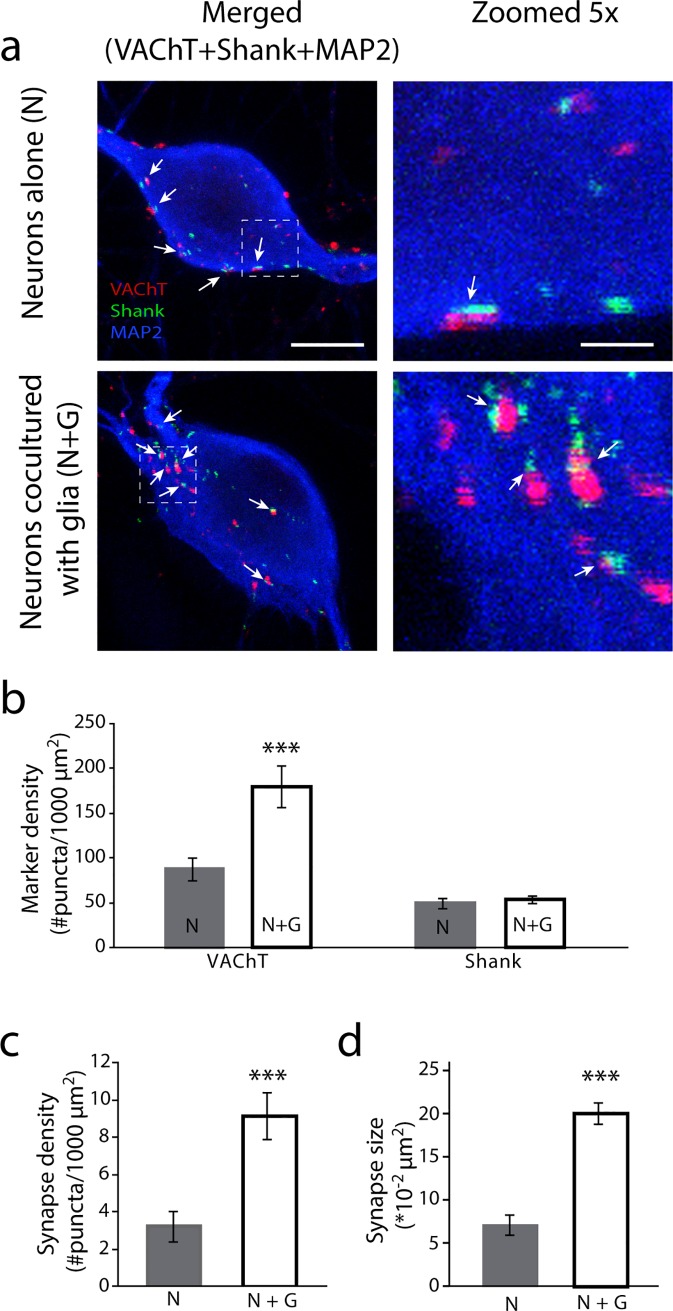
Satellite glial cells enhance cholinergic synapse formation.Neurons cultured in the absence (Neurons alone, N) or presence of satellite glial cells (N+G) were fixed, stained for synaptic markers, and analyzed by confocal microscopy. (a) Representative images of cells stained for the pre-synaptic marker VAChT (red), the post-synaptic marker Shank (green), and the dendritic marker MAP2 (blue). Boxed regions in left panels are magnified in the right panels to show colocalized puncta (arrows). Scale bar represents 10 μm in the left panels; 2 μm in the right panels. (b) Quantification of VAChT and Shank puncta on sympathetic neuronal soma and proximal dendrites showing a glia-dependent increase in the expression of VAChT, but not Shank-containing puncta (n ≥ 61 cells, unpaired t-test ***p<0.001 and n.s., respectively). Quantification of co-localized synaptic puncta density (c) and size (d) on neuronal soma and proximal dendrites showing that glia induce structural synapse formation (n ≥ 61 cells, unpaired t-test, ***p<0.001, **p<0.01, respectively).